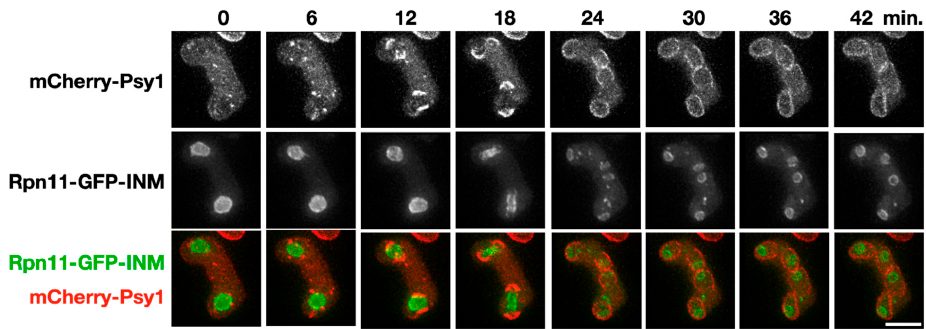
Figure 4. Forespore membrane (FSM) assembly in the rpn11-gfp- INM cells. A representative time-lapse image of FSM assembly during meiosis II in the rpn11-gfp- INM cells. The FSM is labeled by mCherry-Psy1 (red). The nuclei are outlined by the signal of Rpn11-GFP-INM (green). Scale bar: 5 µ m.